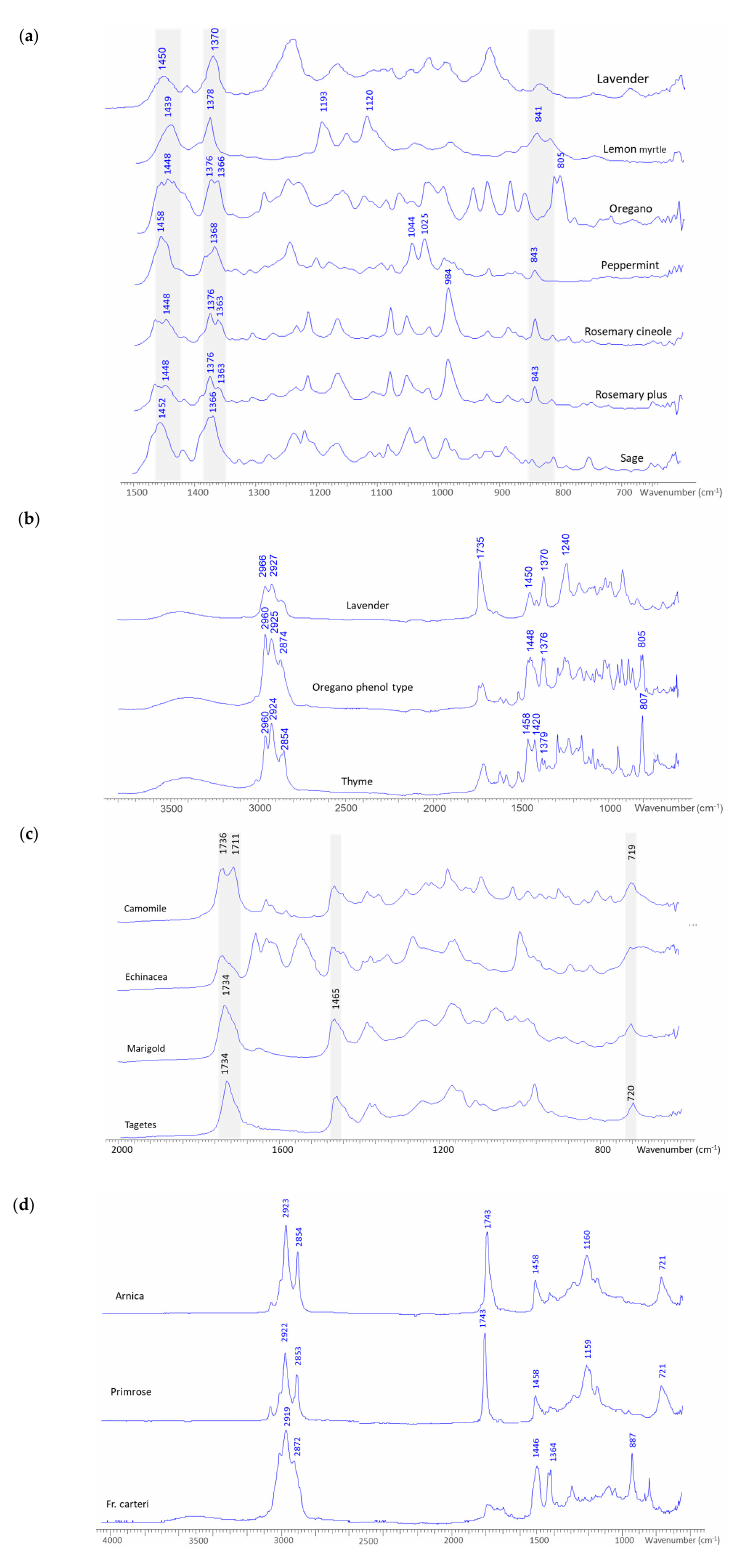
Figure 3. ATR-FTIR spectra for ( a ) Lamiaceae cluster with positive correlation (lavender, lemon myrtle, oregano terpineol type, peppermint, rosemary cineole type, rosemary plus and sage essential oils); ( b ) lavender against Lamiaceae cluster with negative correlation (oregano phenol type, and thyme); ( c ) Asteraceae cluster (chamomile, echinacea, marigold and tagetes) and ( d ) mixed oil samples cluster (arnica, primrose and frankincense).